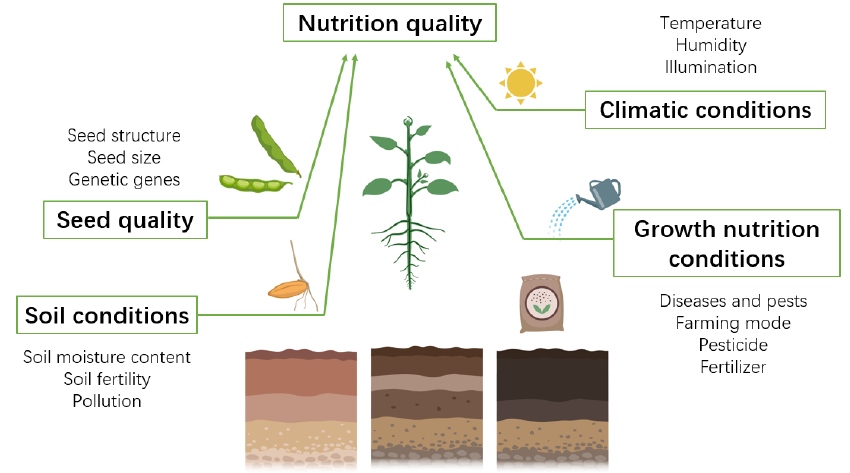
Figure 1. Influencing factors of crop nutrition quality.